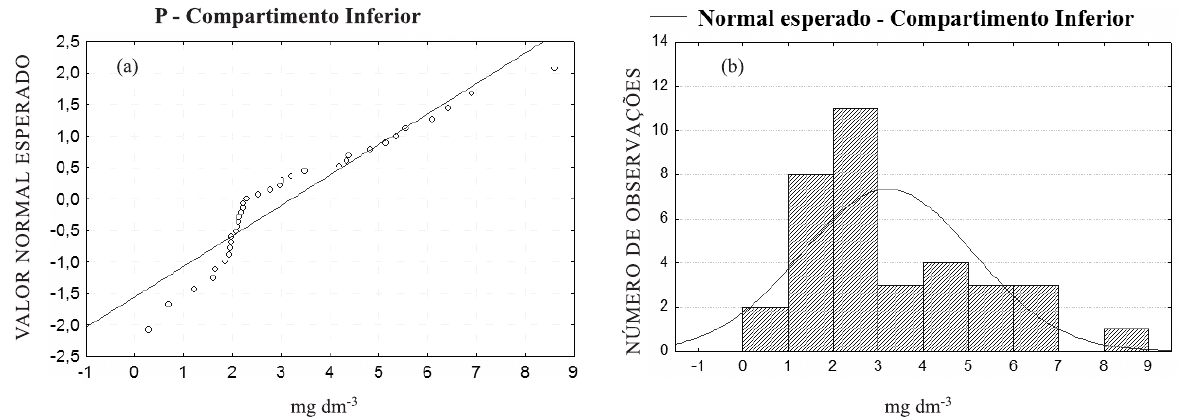
Figura 4. Gráfico de normalidade (a) e distribuição das classes de frequência (b) dos teores de P no compartimento